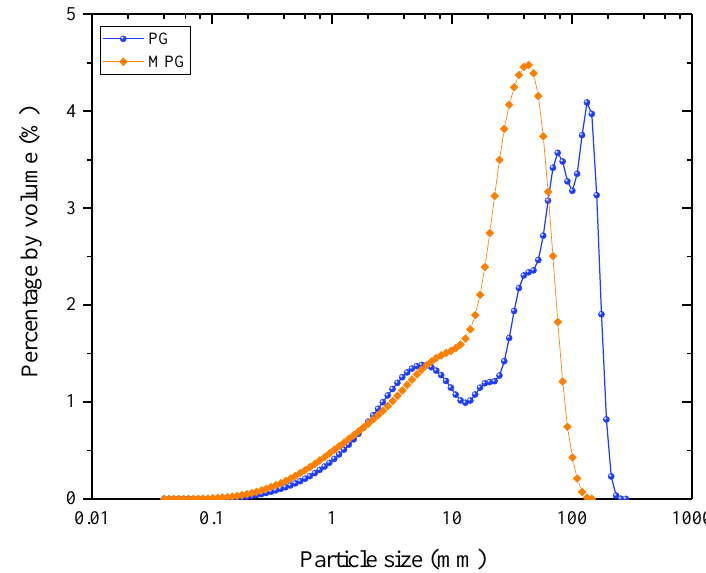
Figure 3. Particle size distribution curves of PG and MPG.